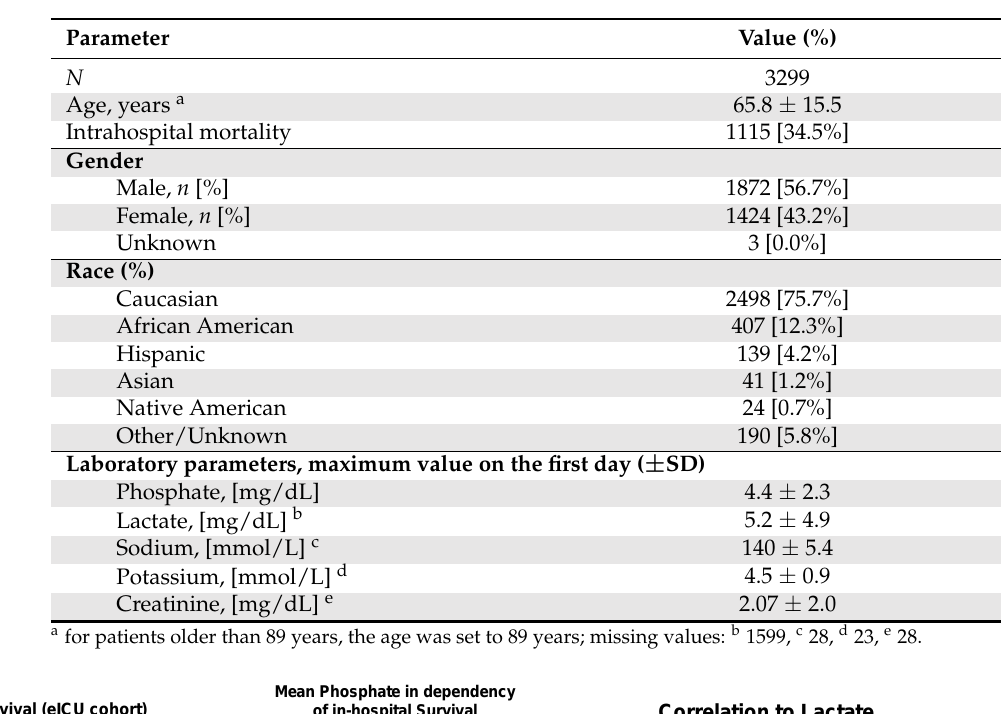
Table 2. Demographics of the collective from the eICU database.